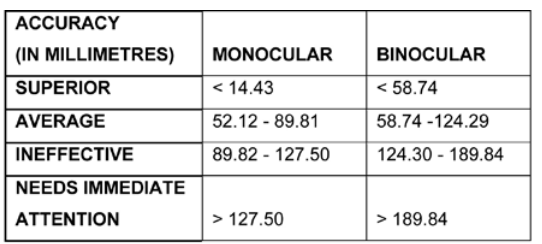
Table 8: The norms for accuracy: monocular and binocular aim-